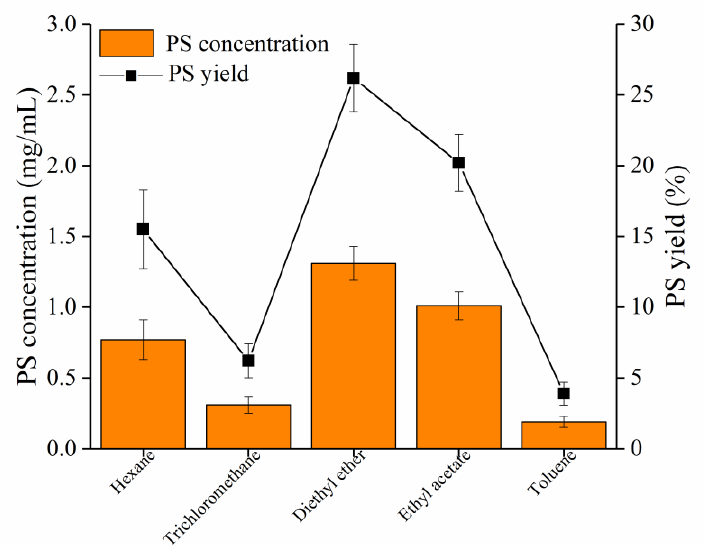
Figure 4. Application of SkPLD for PS synthesis. Effect of different organic solvents on the yield of PS. Values were means ± standard deviation from three independent